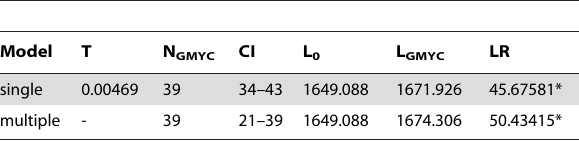
Table 1. Lineage branching pattern fit to single- and multiple threshold variants of the GMYC